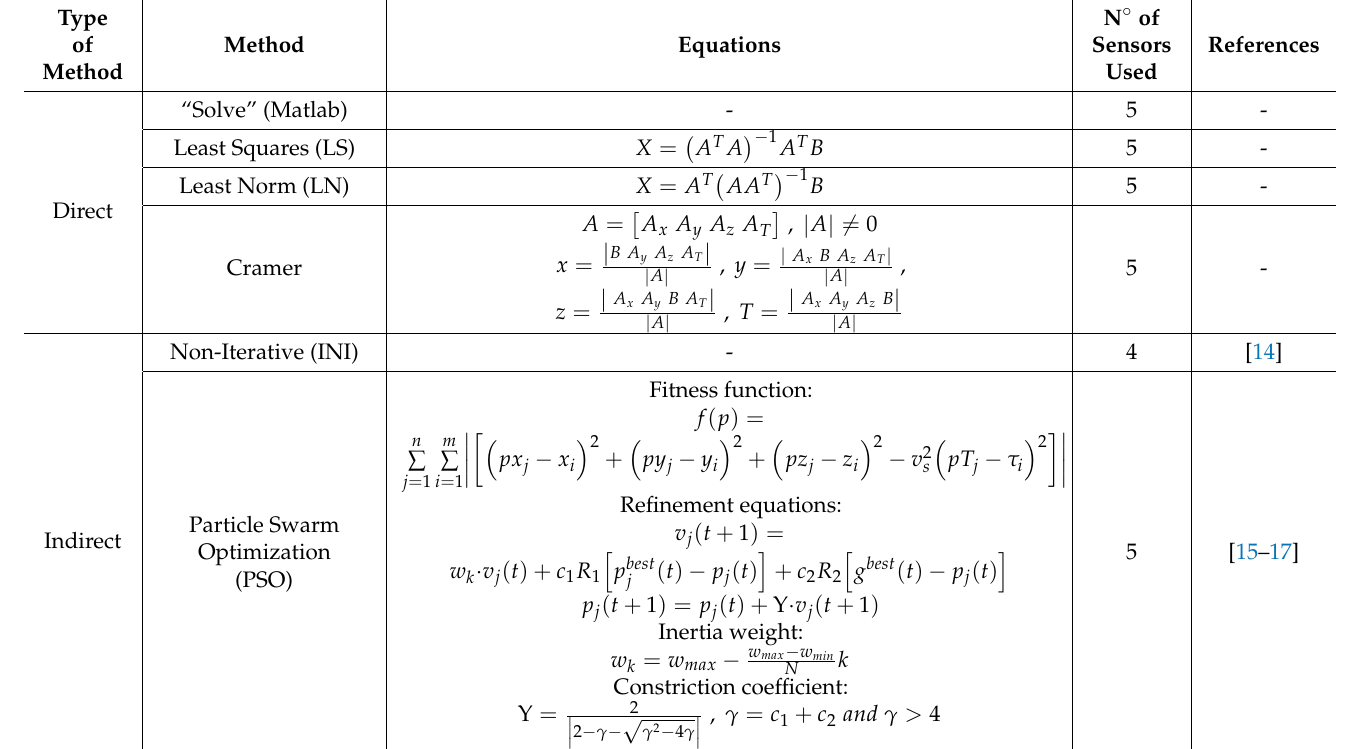
Table 1. Location solution